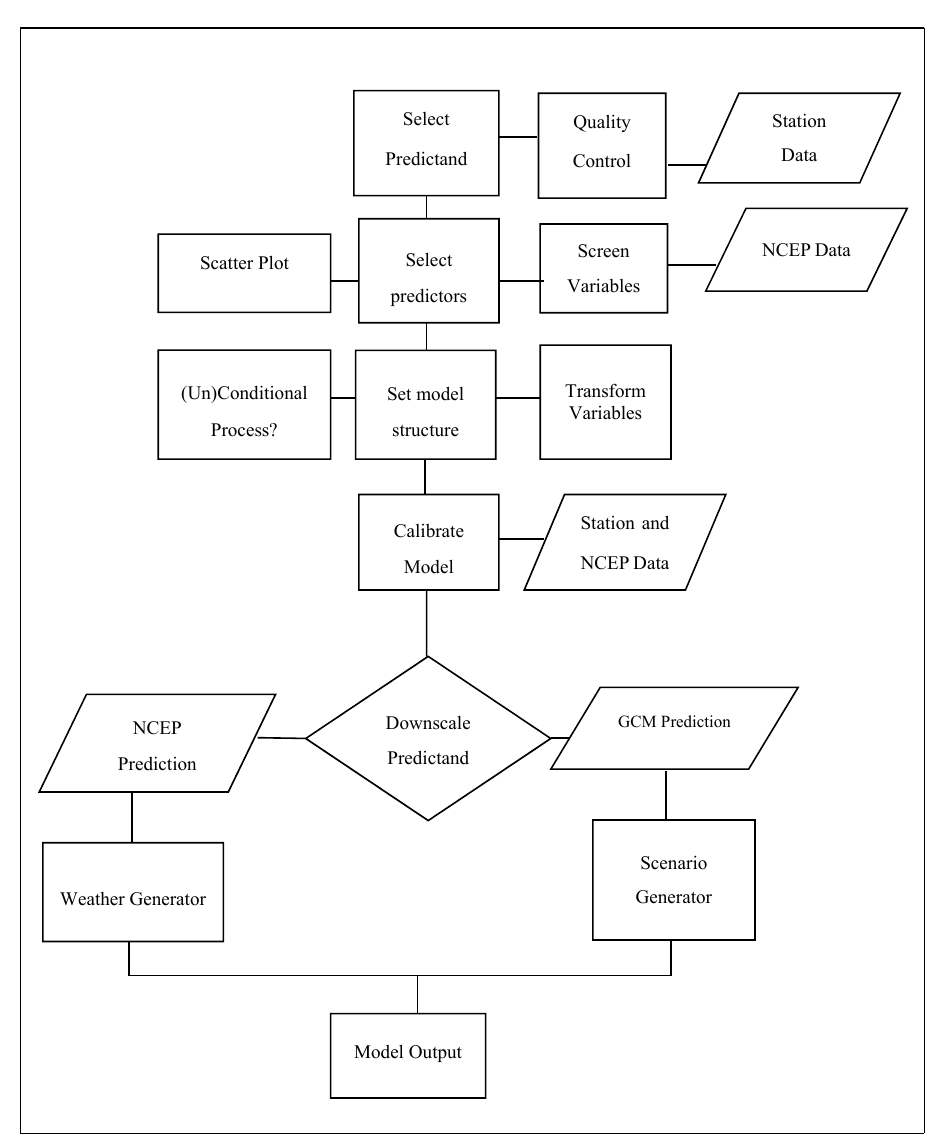
Figure 2. SDSM Version 4.2 climate scenario generation, adapted from [39].